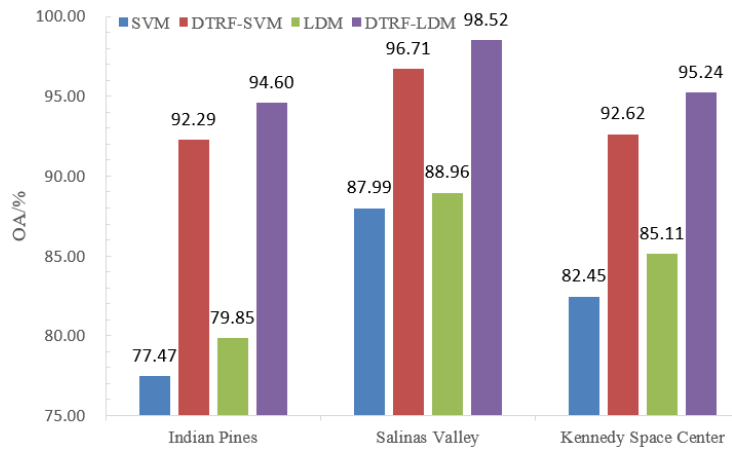
Figure 13. Comparison of SVM, DTRF-SVM, LDM and DTRF-LDM on three datasets.